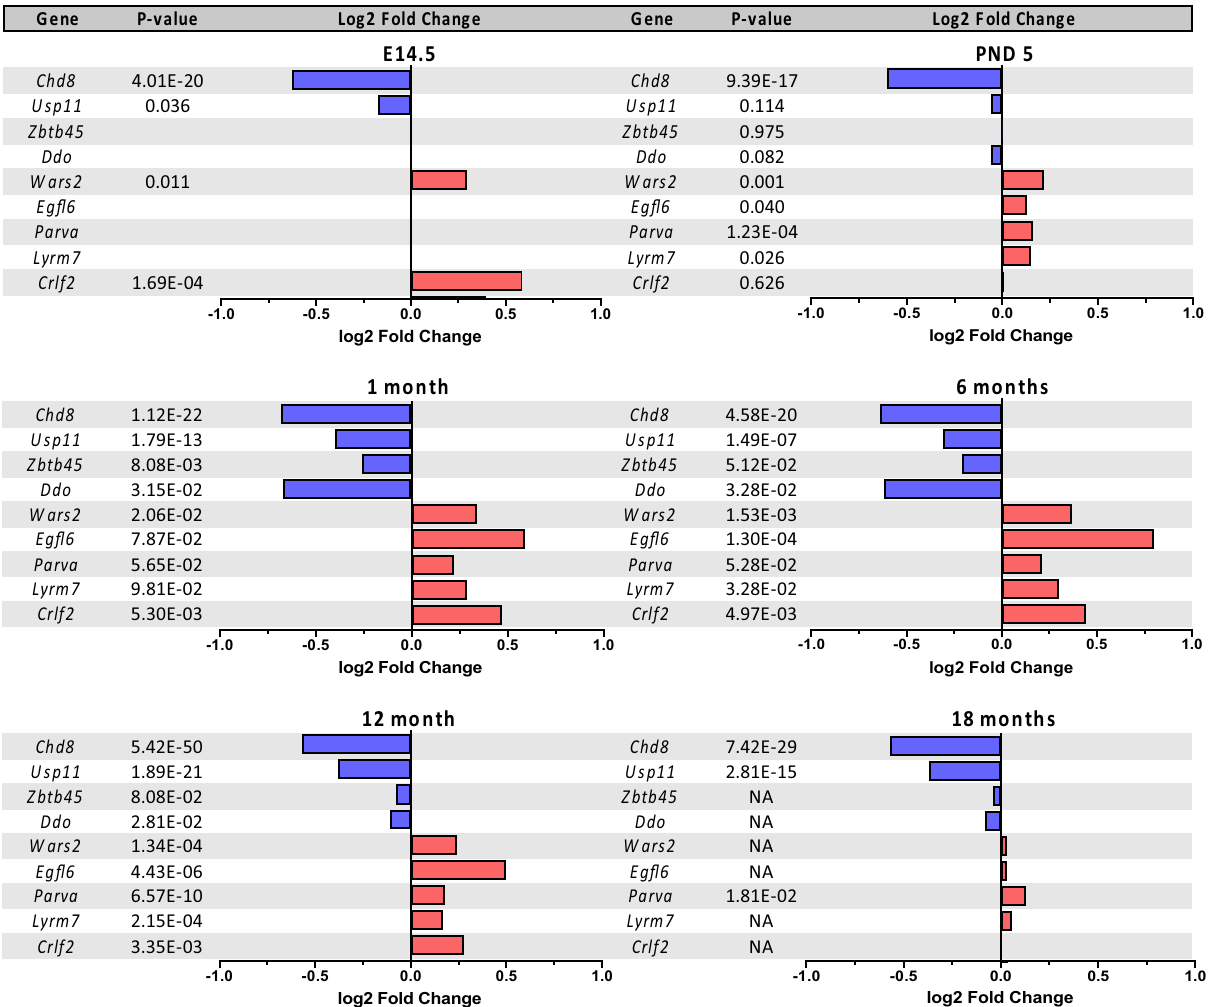
Figure 7. Core set of DEGs in oil-exposed Chd8 V986*/ + mice relative to WT mice, determined by bulk RNA- sequencing of cortical tissue at E14.5, PND 5, 1 month, 6 months, 12 months, and 18 months. These core genes were significantly changed at multiple ages. Adjusted p-values and log2 fold changes from E14.5, 1 month, and 6 month old animals were obtained from our previous study 14